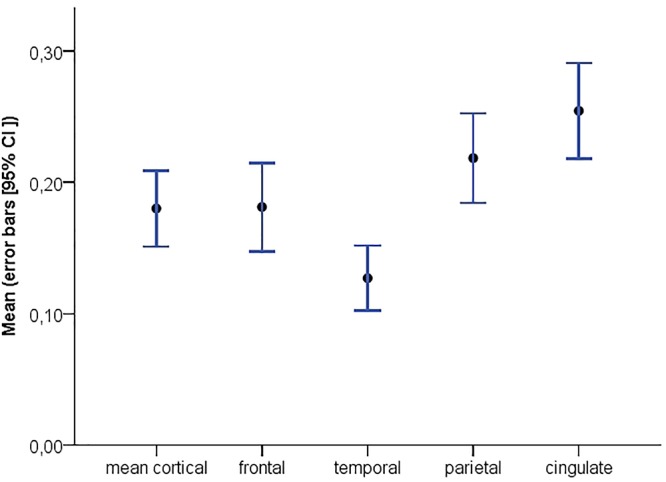
Distribution of global and regional [18F]florbetapir BPND with corresponding 95% confidence intervals.